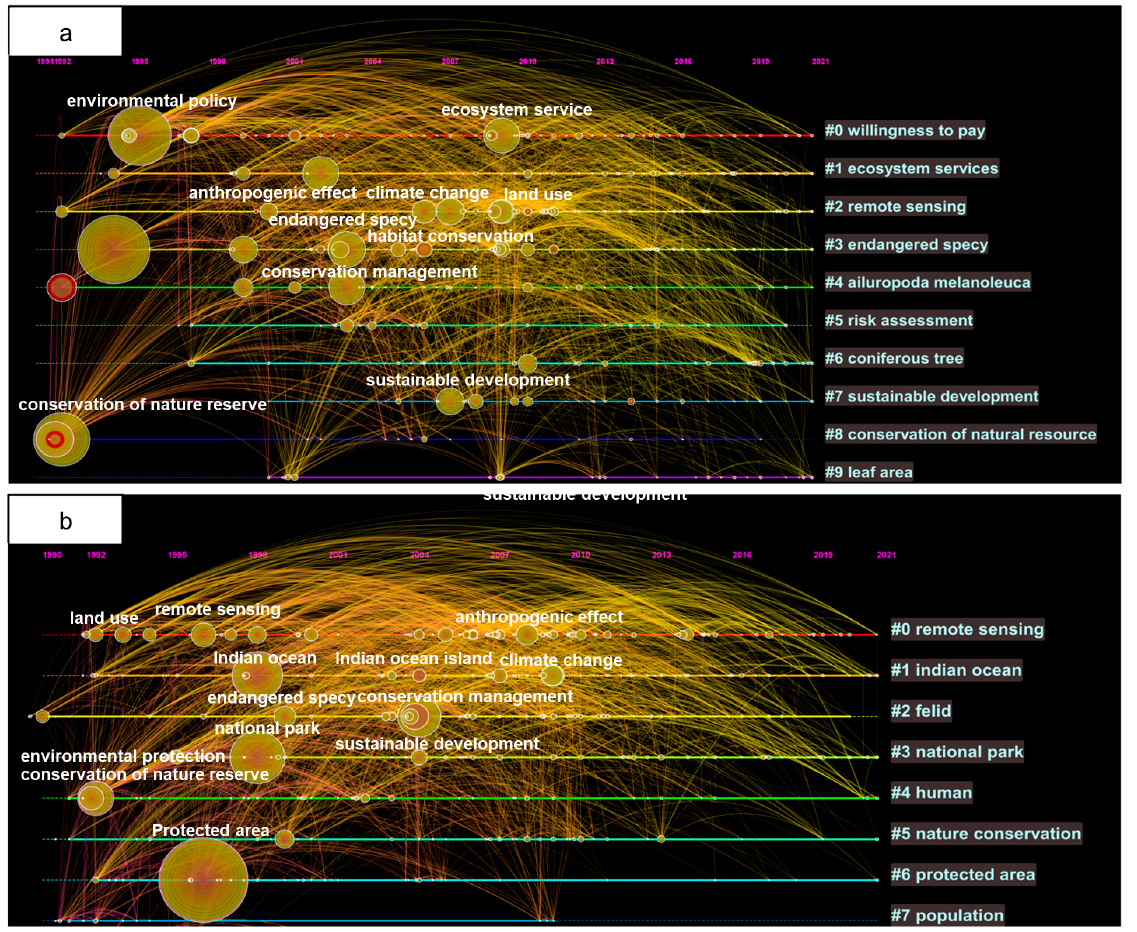
Figure 6. A timeline view of keywords in CPAP ( a ) and IPAP ( b ) research. The node locations demonstrate the first years of the keyword appearance. The node sizes represent the keyword frequency, and the connections between nodes represent the co-occurrence intensity. Important nodes (centrality > 0.1) are externally covered with the purple outer ring.